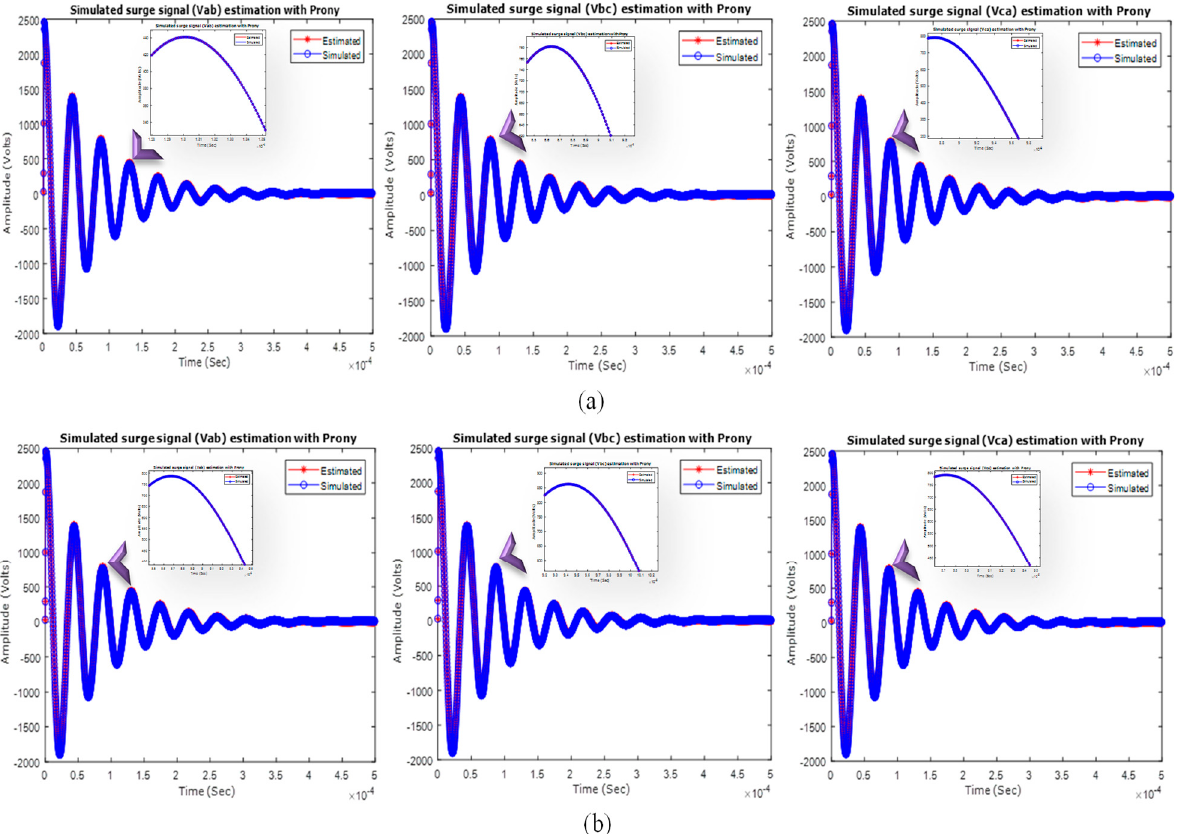
Figure 5. Simulated surge waveforms estimation ( a ) No fault ( b ) Fault. Table 4. Error parameter ratio percentage of line-to-line estimated signal parameters of simulated surge waveforms (No fault and